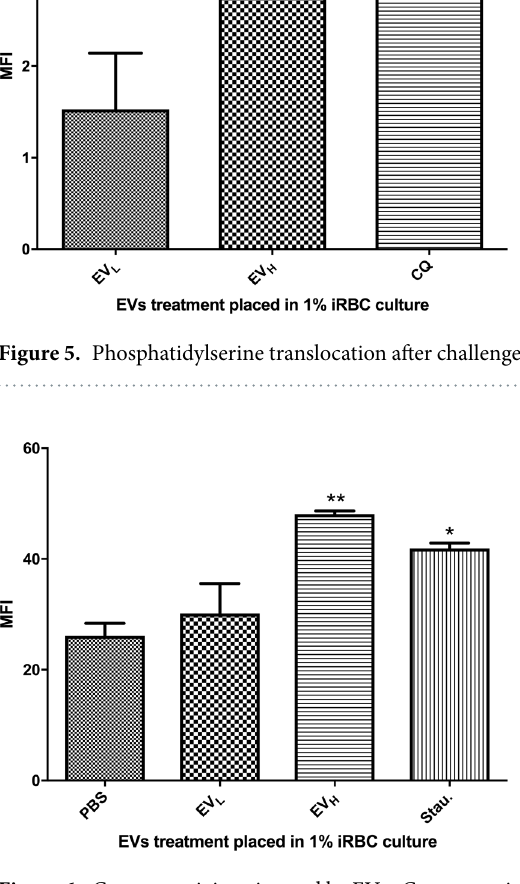
Figure 6. Caspase activity triggered by EV H . Caspase activity detection after EV treatment. MFI was measured after distinct EV treatments by flow cytometry. The average and S.D. of 3 replicas for each treatment is shown. (mean ± s.e.m.; n = 3 replicas), * P < 0.05, ** P < 0.01, EV L versus EV H (Bonferroni’s